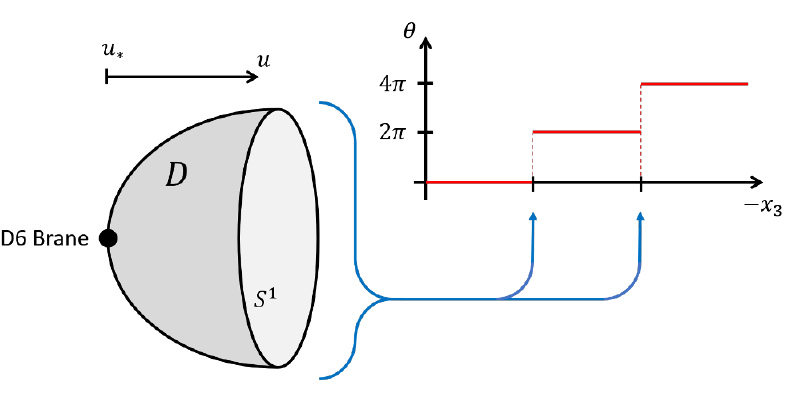
Figure 4 . Con(cid:12)guration of D6